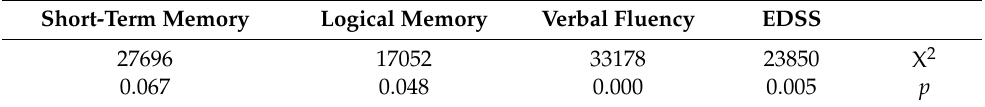
Table 7. Multivariate regression